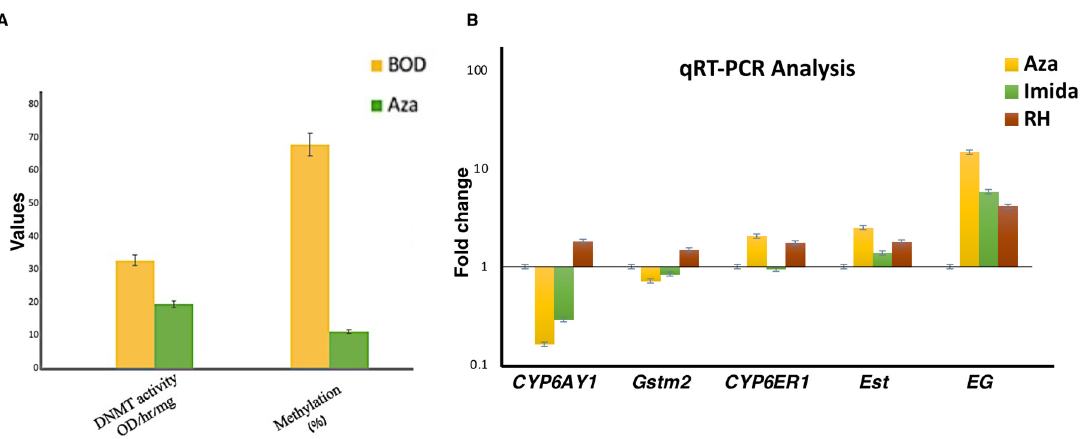
Figure 9. Effect of pharmacological disruption of methylome (5 ′ -azacytidine treatment) on BPH ( A ) Bar plots showing reduction in cellular DNMT levels and percent methylation across stress- responsive genes in BPH after treatment with azacytidine. Error bars represent SD. ( B ) Quantitative RT-PCR-based analysis of gene expression performed for BPH populations after treatment with azacytidine and upon exposure to stress (Imidacloprid and nutritional stress). BOD population (untreated and unexposed to stress) was used as a control. The relative gene expression was normalised to the expression level of Actin . The results were analysed using the 2 −ΔΔ Ct method, and the expression level was displayed as relative expression values based on the relative standard curve method. The analysis was based on three biological and three technical replicates.